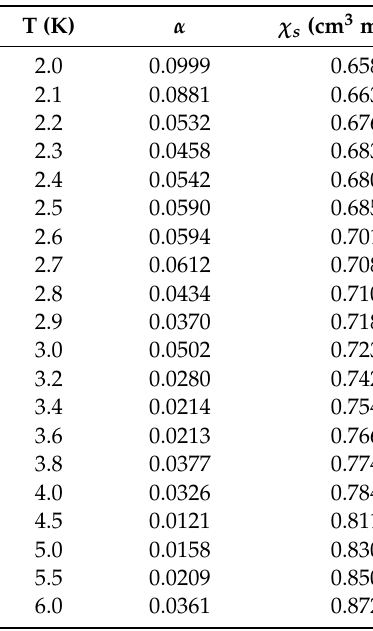
Table 3. Parameters obtained from the fit of the out-of-phase AC signal ( χ m ”) of compound 1 to the Debye model (Equations (2) and